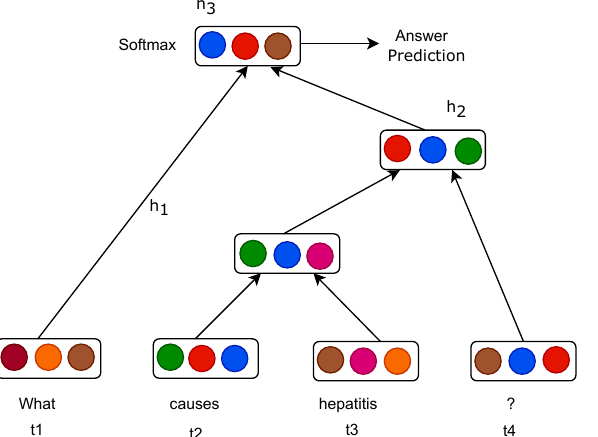
(cid:16) (cid:104) (cid:105)(cid:17) t 2 w ; h 2 = f t 3